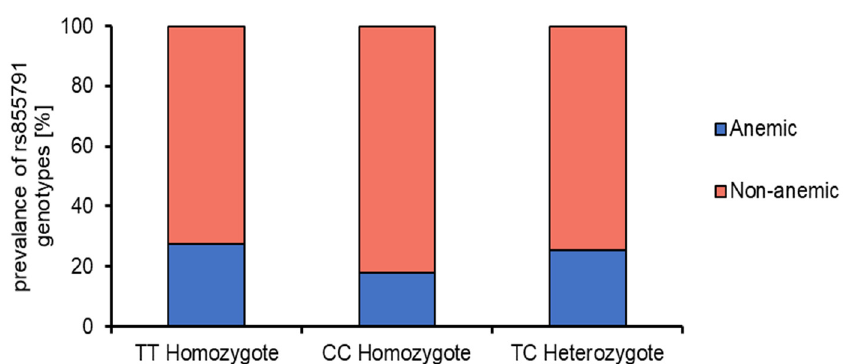
Figure 1. Proportion of the frequency between the polymorphism varieties in anemic and non-anemic children with celiac disease.